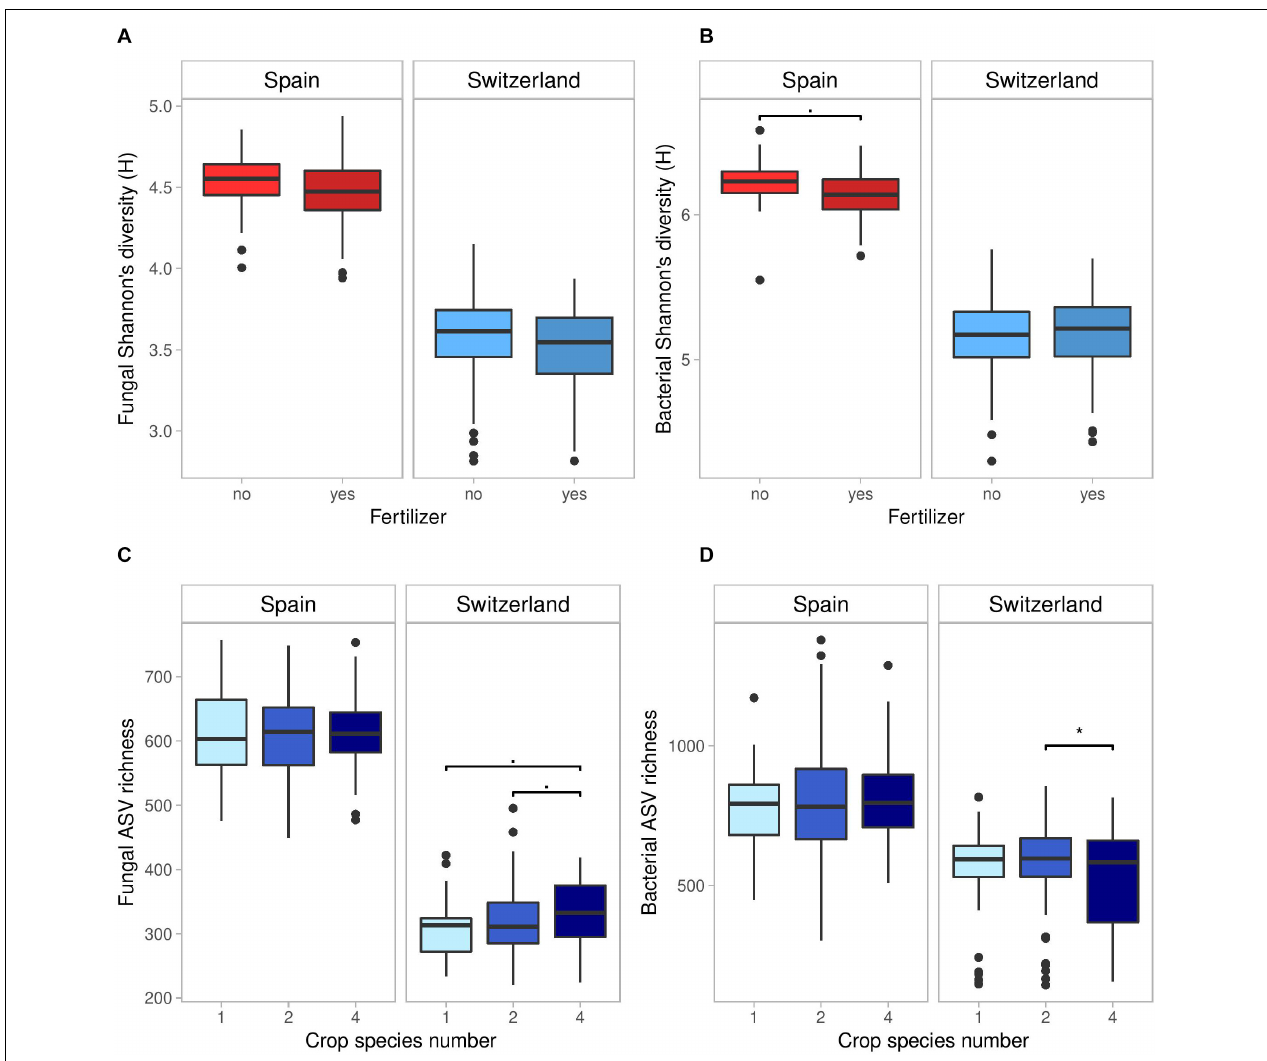
FIGURE 1 | Effects of fertilizer on fungal (A) and bacterial (B) Shannon’s diversity index (H), and of crop species number on fungal (C) , and bacterial (D) ASV richness in Spain and Switzerland. Horizontal lines represent the median of the data, boxes represent the lower and upper quartiles (25 and 75%), with vertical lines extending from the hinge of the box to the smallest and largest values, no further than 1.5 × the interquartile range. Data beyond the end of the whiskers are outlying and plotted individually. See Tables S2 and S3 for the results of the statistical